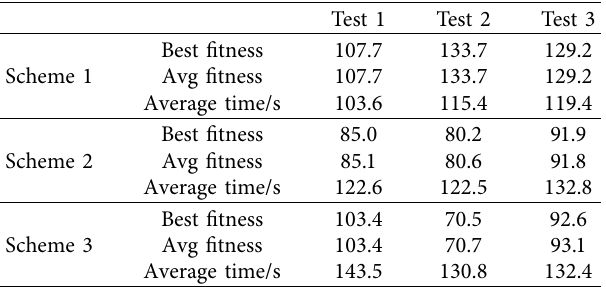
Figure 5: The changes of fitness for three algorithms. (a) Modified optimization algorithm. (b) ESGA. (c) SGA. Table 2: Random test of three schemes.